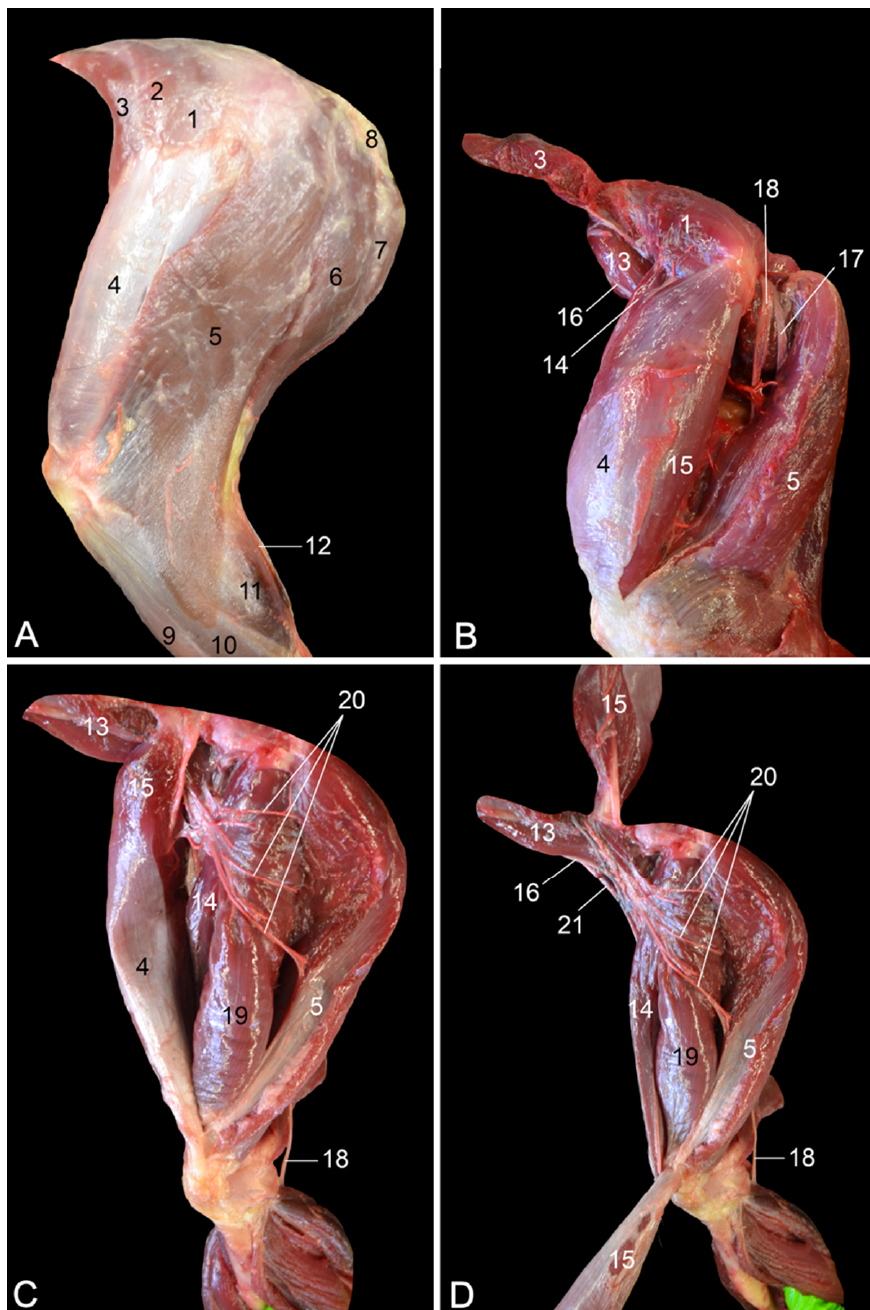
Figure 3. Craniolateral views of the left upper hindlimb. ( A ) Superficial layer; ( B ) second layer after the retraction of the m. tensor fasciae latae and the separation of the m. vastus lateralis from the m. biceps femoris; ( C ) third layer after the m. tensor fasciae latae was removed and the m. vastus lateralis was maximally withdrawn from the m. biceps femoris; ( D ) deepest layer after the m. vastus lateralis was distally retracted. 1: M. gluteus superficialis; 2: m. gluteus medius; 3: m. tensor fasciae latae; 4: fascia lata; 5: m. biceps femoris; 6: m. semitendinosus; 7: m. semimembranosus; 8: callositas ischii; 9: m. tibialis cranialis; 10: m. fibularis longus; 11: m. gastrocnemius caput laterale; 12: v. saphena lateralis; 13: m. iliopsoas; 14: m. rectus femoris; 15: m. vastus lateralis; 16: n. femoralis; 17: n. fibularis communis; 18: n. tibialis; 19: m. vastus intermedius; 20: muscular branches (rami musculares) of the a. glutea caudalis; 21: a. + v. femoralis.